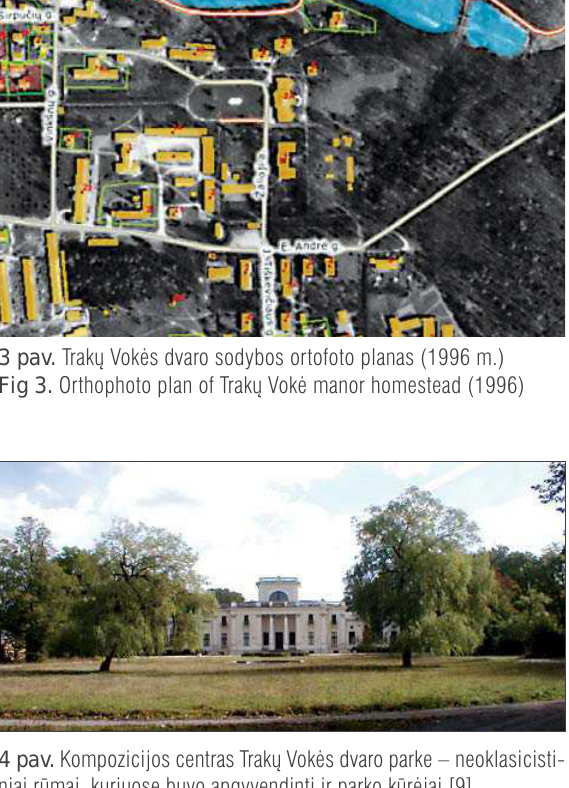
Fig 4. Neoclassical manor house in the centre of composition in Trakų Vokė manor